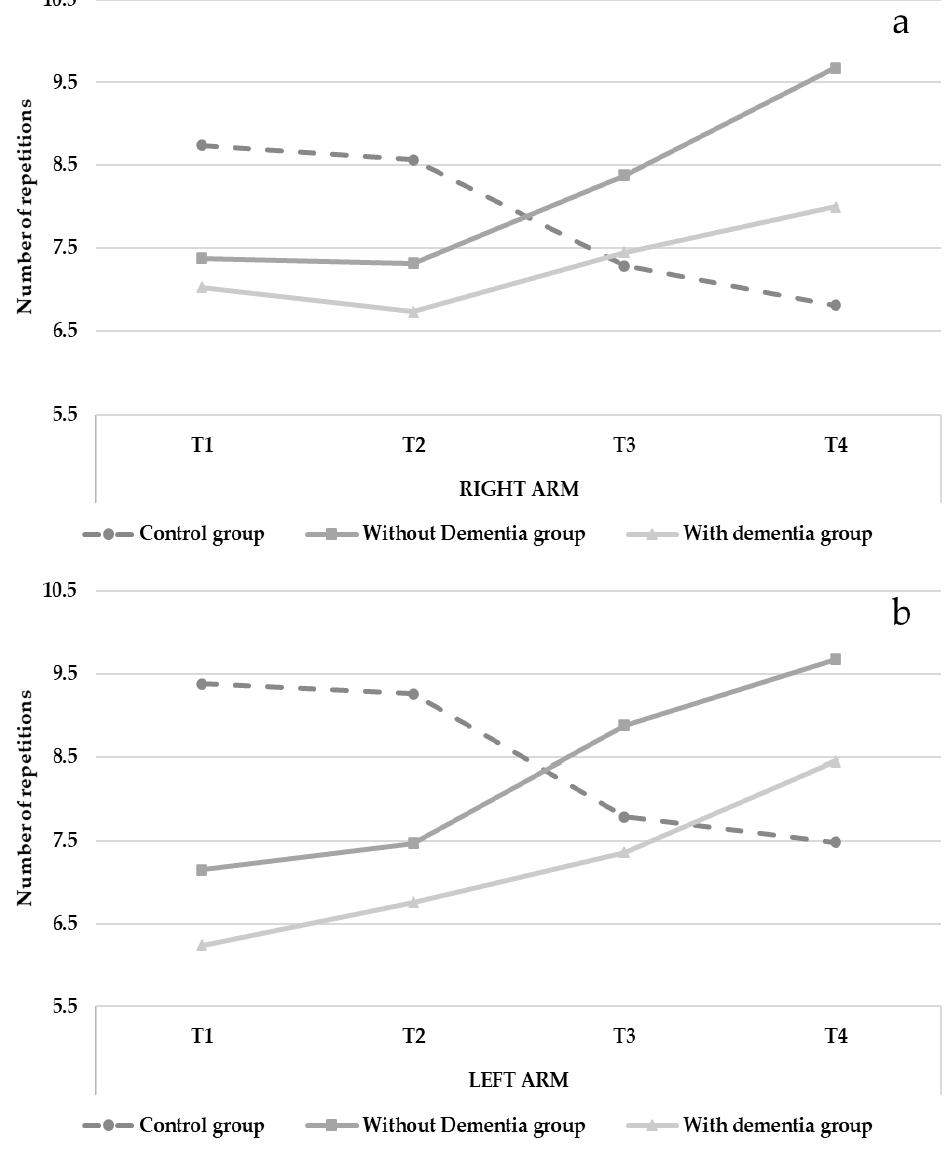
Figure 3. Changes in upper limb strength (Arm curl test) over time (right arm = a ; left arm = b ).